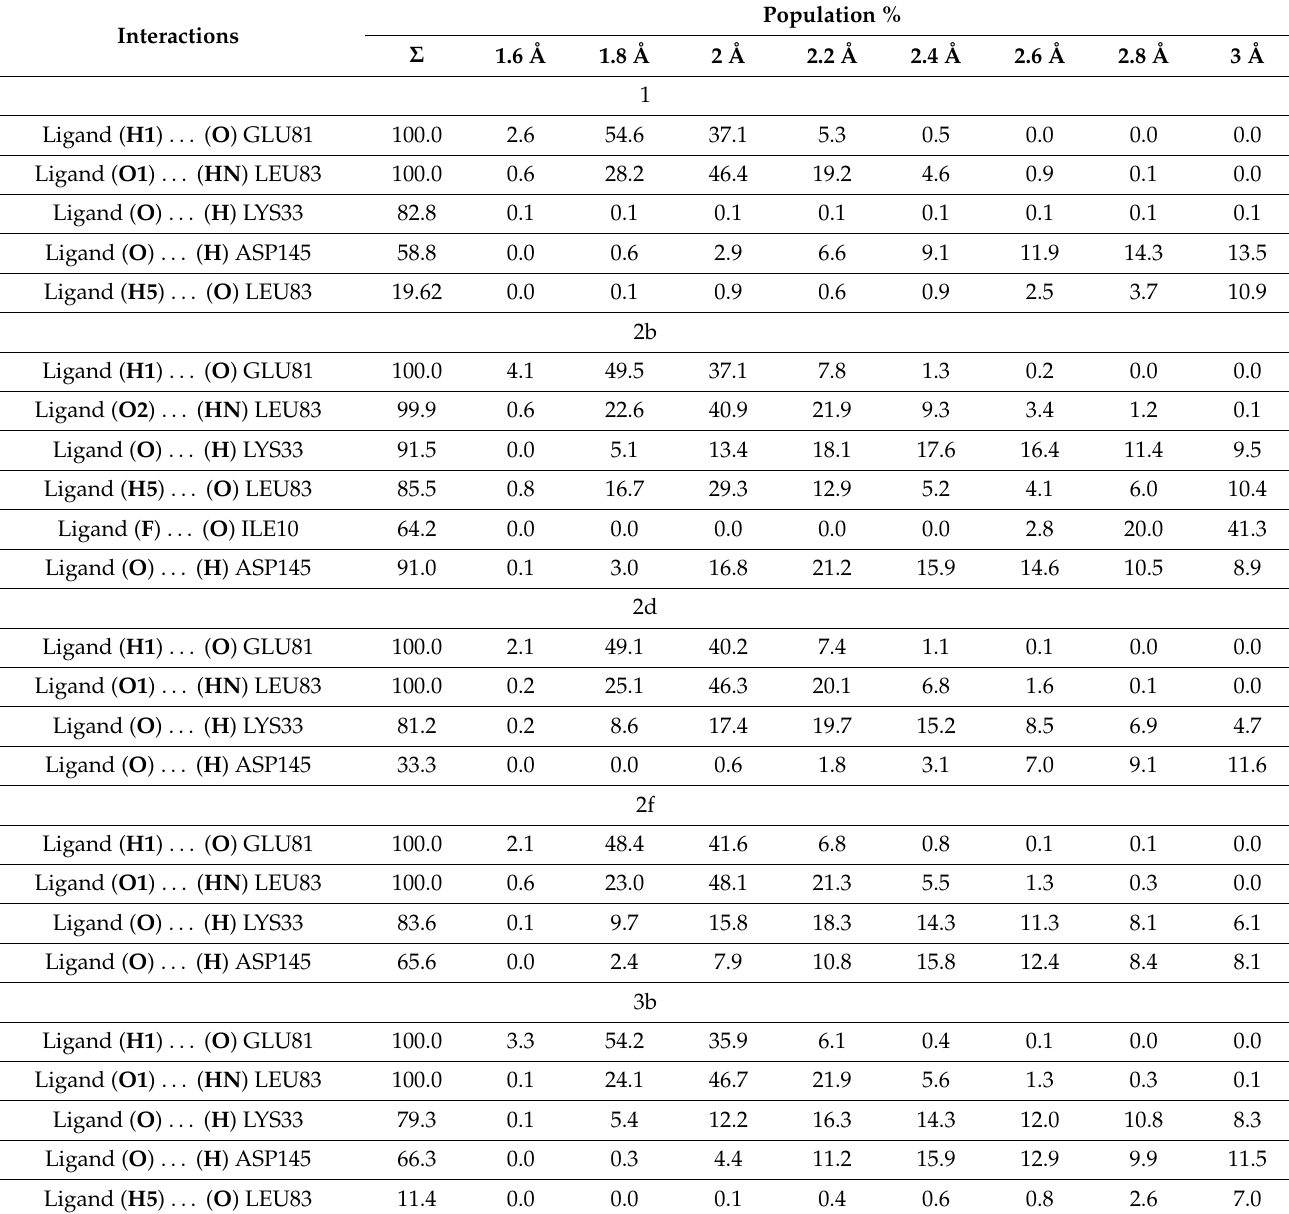
Table 5. The cumulative analysis of the length of the interactions identified in CDK2 complexes with selected 5-nitroisatin-based benzoylhydrazines. The distances presented in the table represent the middle values of intervals with a width of 0.2